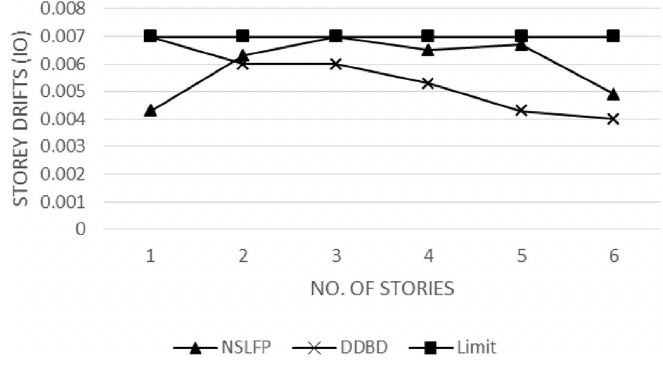
FIG. 3. STOREY DRIFTS FOR IO PERFORMANCE LEVEL